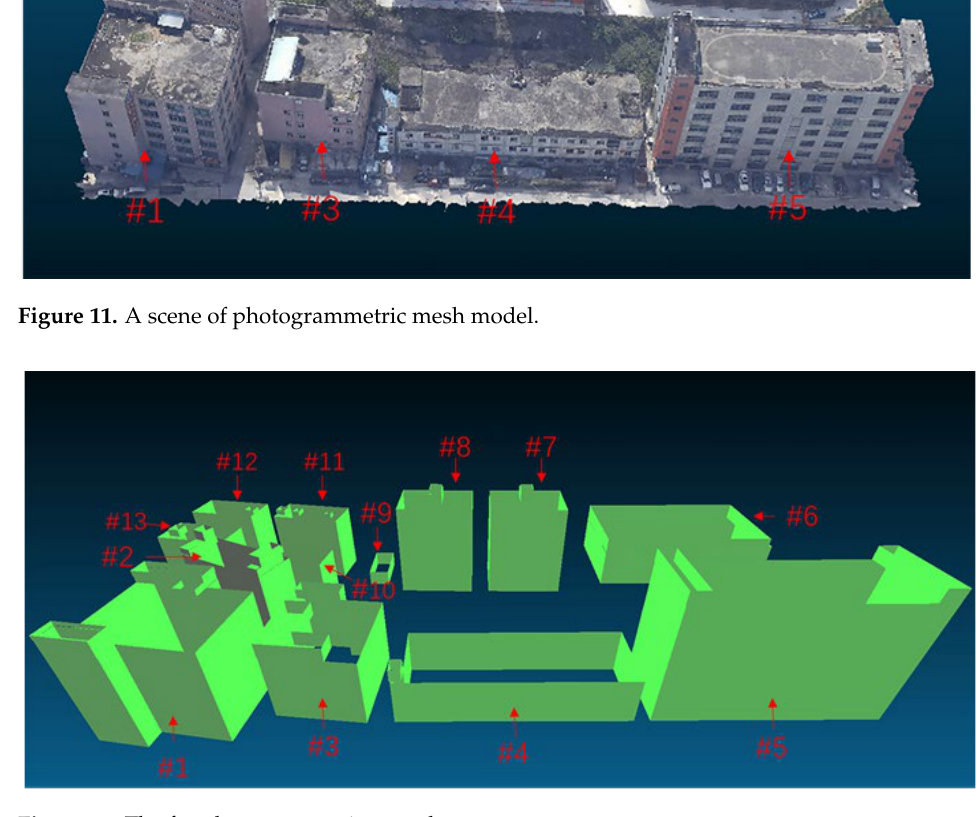
Figure 13. The statistical results of the reconstruction errors for a scene.